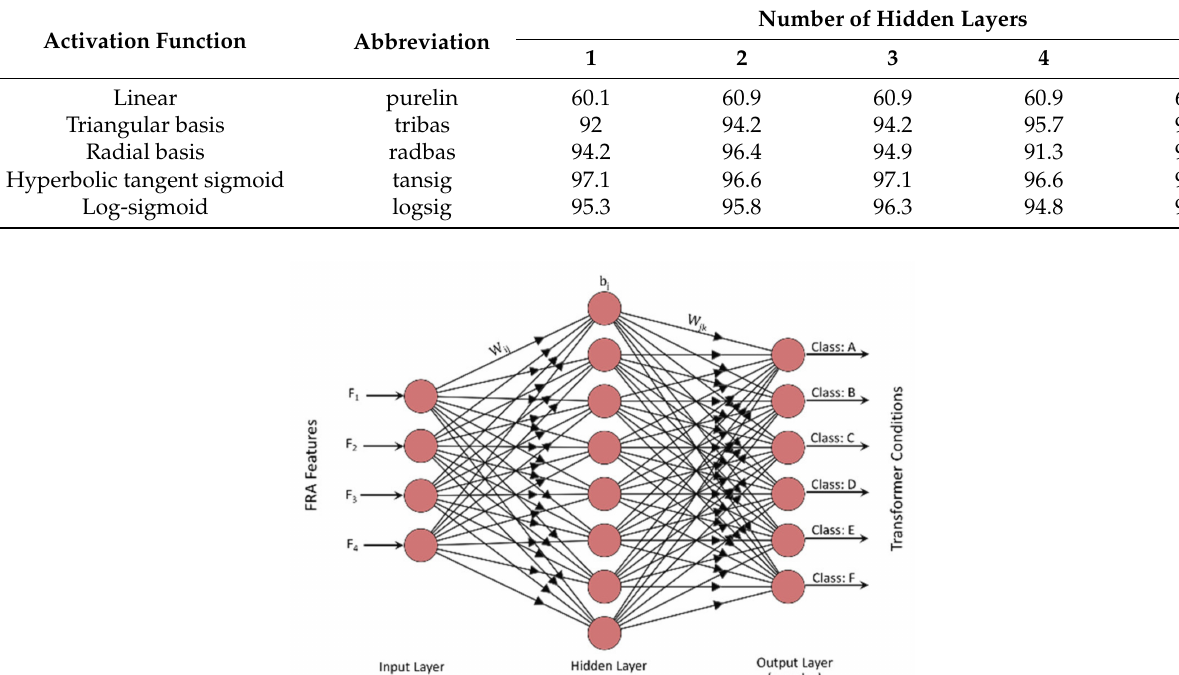
Table 1. Percentage overall accuracy for different activation functions and number of hidden layers.